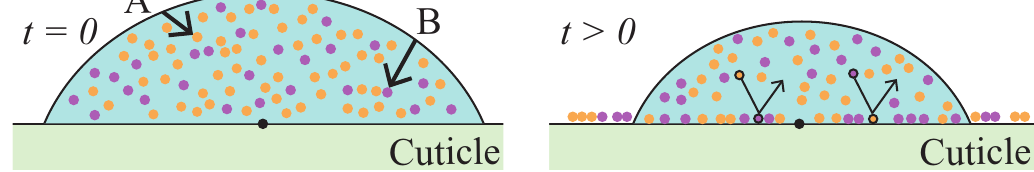
Figure 1. The Adaptive Competitive Langmuir model that includes adsorption and desorption. The initial condition is at t = 0 and t > 0 is a short time later after some droplet evaporation has occurred. Two generic molecules A (orange circles) and B (purple circles) sit on the cuticle surface. Initially, A and B are in a droplet solution. Then as time progresses, A and B adsorb and desorb in a competitive process. As the droplet has moved due to evaporation, some of the molecules have been left behind. We note A in this case is ionic AI and B is lipophilic adjuvant. This figure is a simplification and describes the Adaptive Competitive Langmuir model and moving droplet radius, and we note other processes are involved in droplet evaporation, as described in text (not to